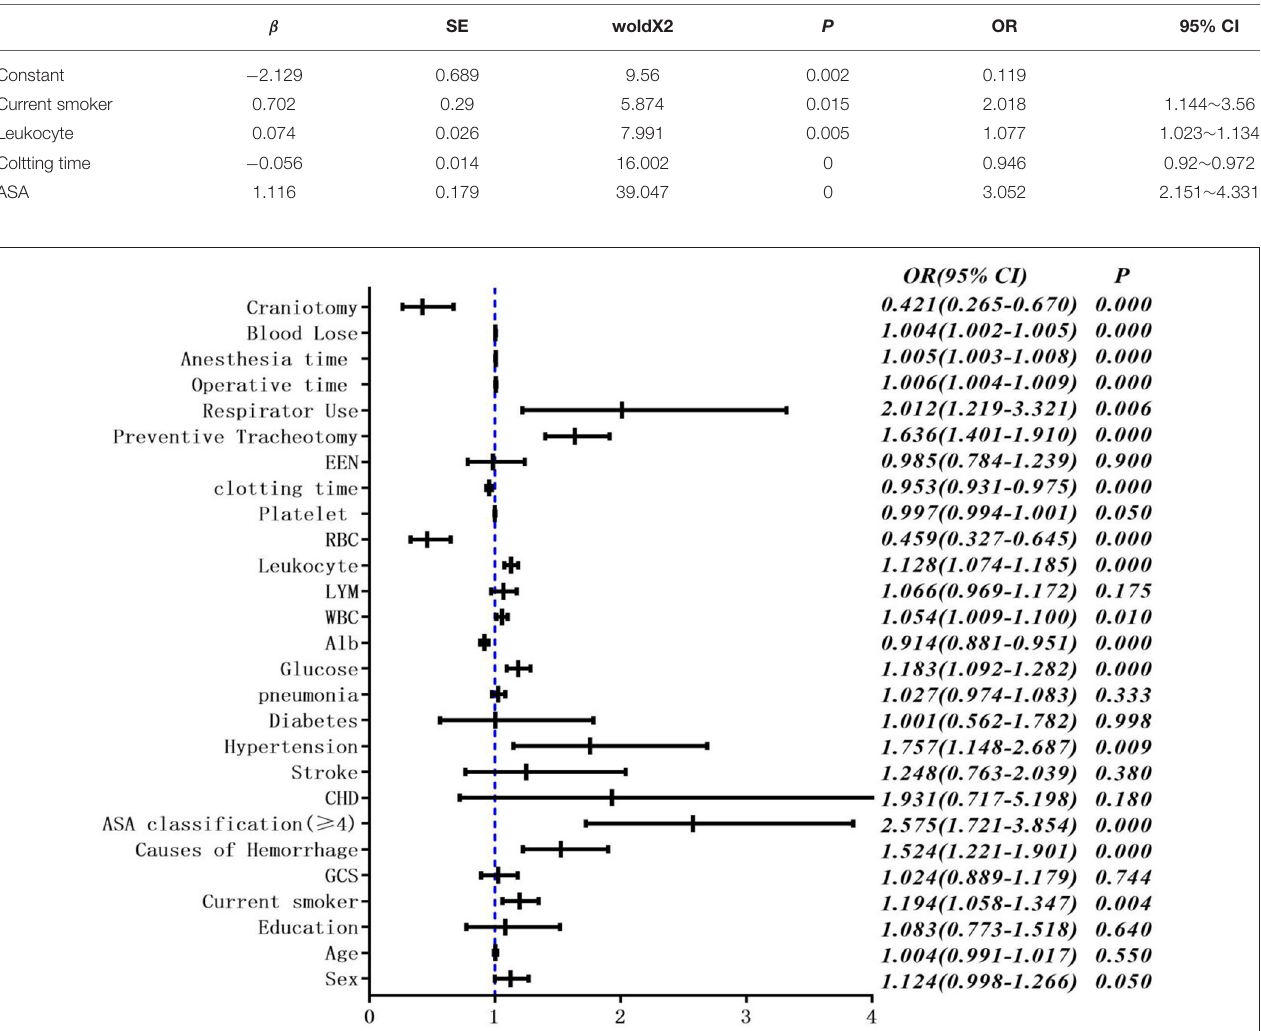
TABLE 2 | Multivariate unconditional Logistic regression analysis of postoperative pulmonary complications.